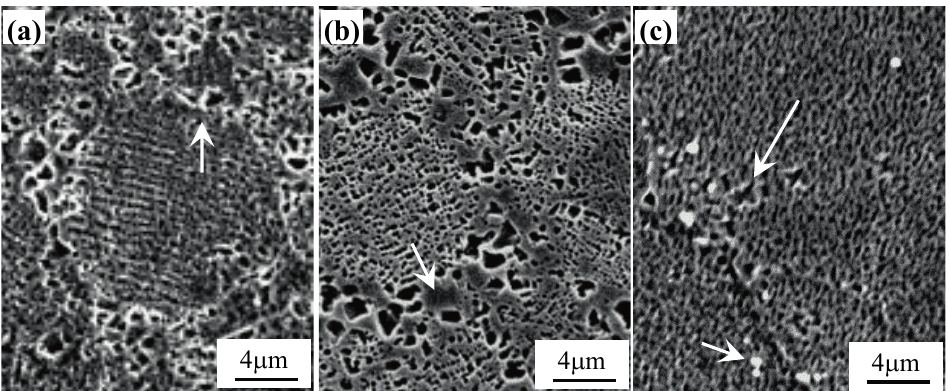
Figure 2. Magnified morphology of the alloy after HIP treated at different temperatures. (a) Previous particle bound- ary marked by arrow in the alloy HIP treated at 1120 ı C, (b) after HIP treated at 1150 ı C, (cid:2) 0 -free phase region near the coarser (cid:2) 0 -phase marked by arrow, (c) after HIP treated at 1180 ı C, finer (cid:2) 0 phase distributed homogeneous along the boundaries, and smaller primary (cid:2) 0 phase distributed along the boundary as marked with longer arrow, and white car- bides discontinuously precipitated in the PPB as marked with short